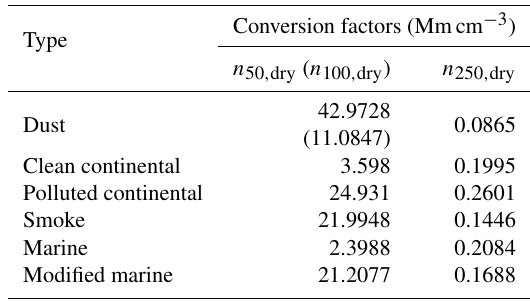
Table 4. OMCAM conversion factors to calculate ANC from Eq.